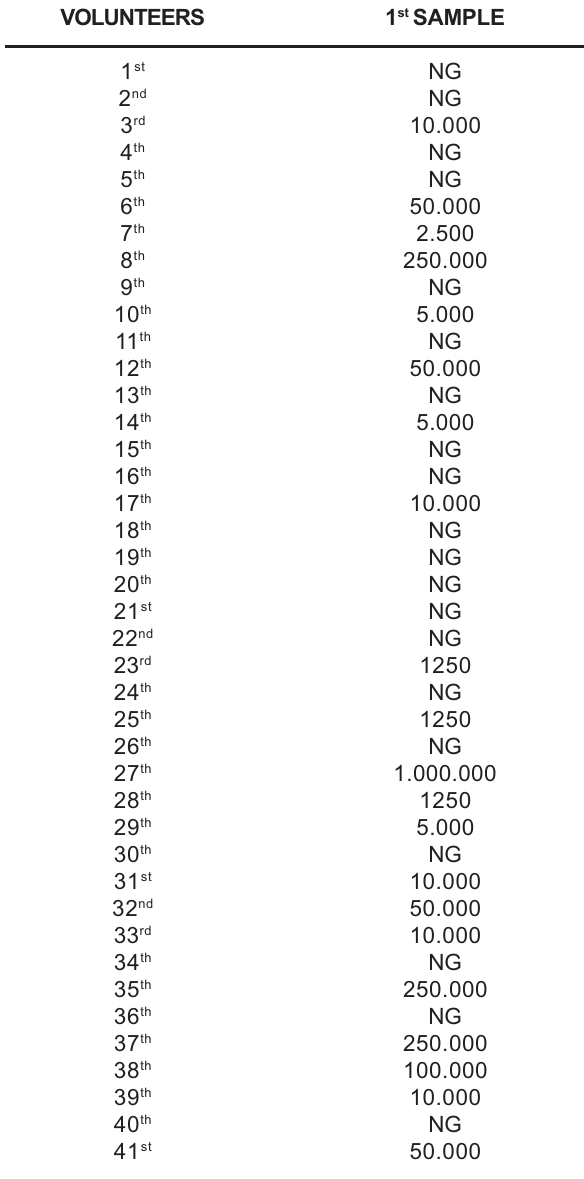
TABLE 1- Number of Streptococcus mutans (CFU/ml) in each saliva